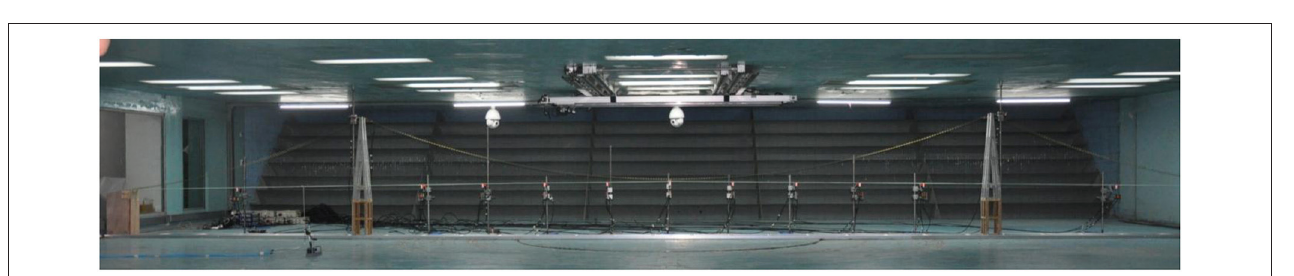
FIGURE 14 | Configuration of slope in wind tunnel (unit: cm). (A)